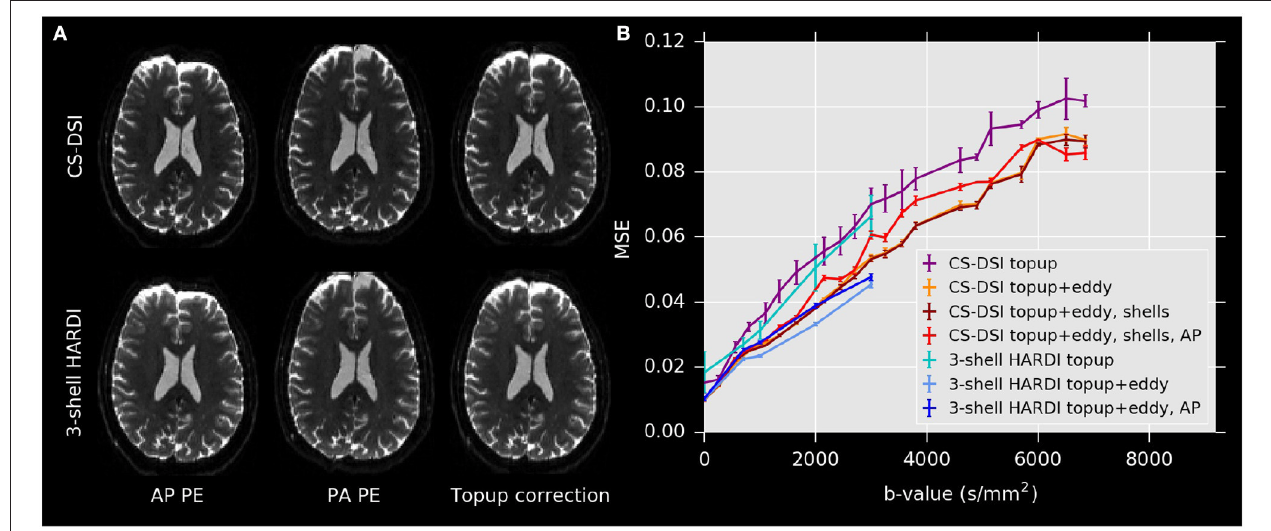
FIGURE 2 | (A) Example b = 0 images with opposite PE directions and following topup correction for CS-DSI and 3-shell HARDI. (B) MSE calculated for the simulated pilot study scenario (“AP”) and between corresponding images acquired with both AP and PA PE directions before and after eddy correction as well as with (“shells”) and without a nominal b -value shift for CS-DSI acquisitions.